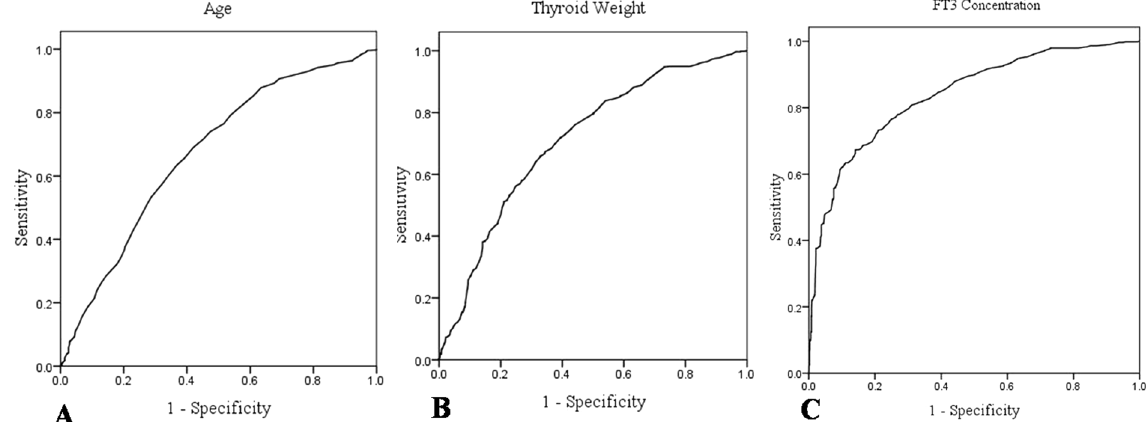
Figure 1. ROC curves for age ( A ), thyroid weight ( B ) and FT 3 concentration ( C ) in predicting rapid thyroidal 131 I turnover in GD patients.